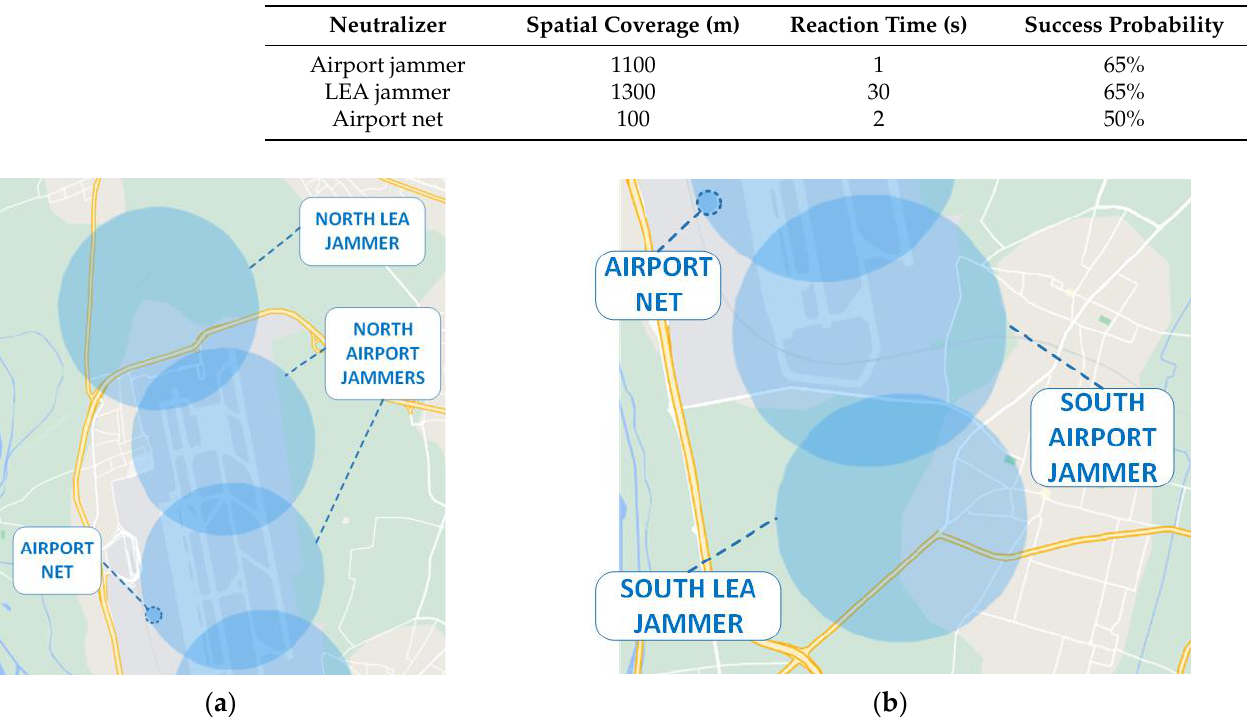
Table 2. Parameter values of the counter-drone sensing entities.